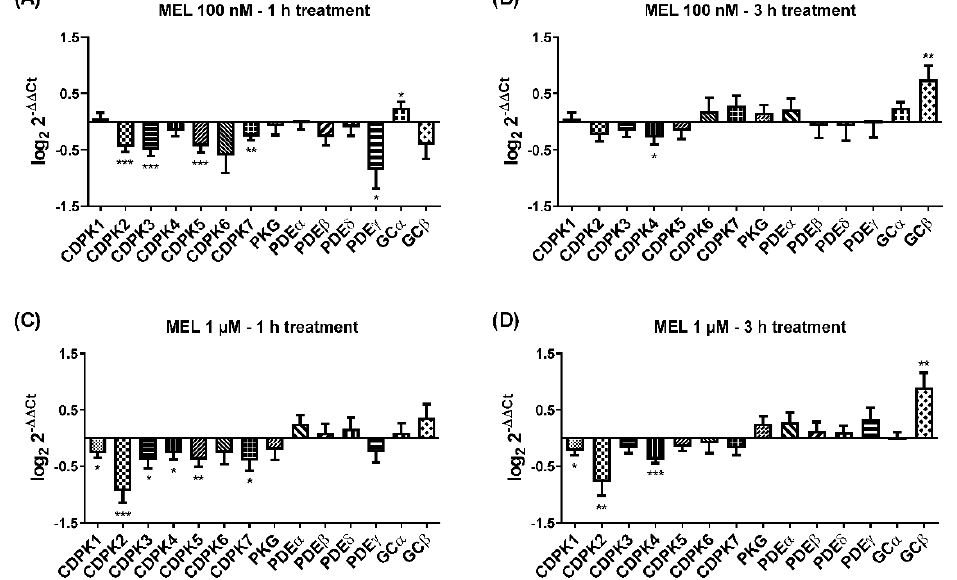
Figure 6. Differential transcription of CDPKs, PKG, and its accessory genes from parasites treated with melatonin for 1 and 3 h. Sorbitol synchronized parasites were treated with melatonin, and RNA samples were extracted, purified, and transcript level was investigated by RT-qPCR. Expression of genes has been normalized by housekeeping seryl-tRNA Synthetase expression for ( A ) 100 nM melatonin for 1 h; ( B ) 100 nM melatonin for 3 h; ( C ) 1 µM melatonin for 1 h; and ( D ) 1 µM melatonin for 3 h. Each figure represents three independent experiments in triplicate. * p ≤ 0.05, ** p ≤ 0.01, *** p ≤ 0.001.